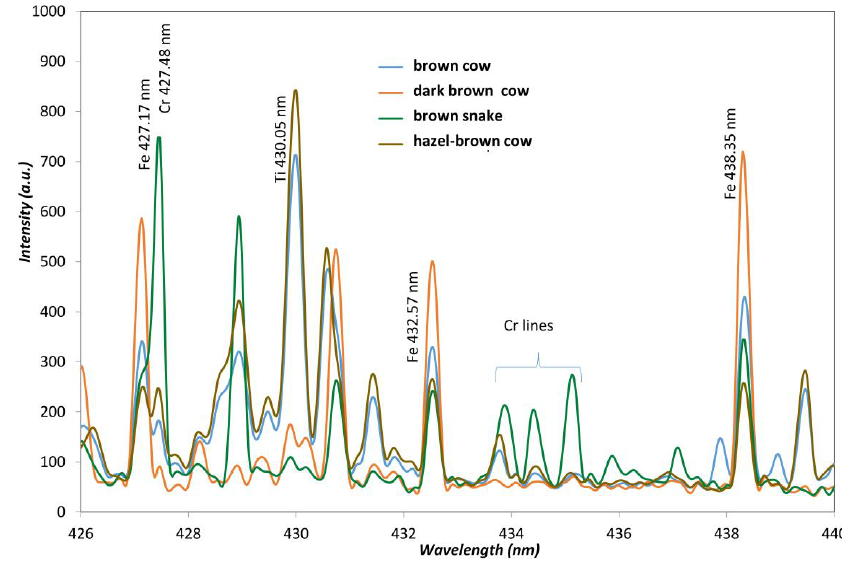
Figure 2. Iron present from brown leathers from cow and snakeskins.